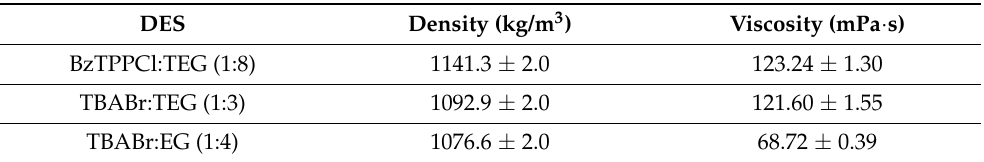
Table 4. Densities ( ρ ) and viscosities ( η ) of the prepared DESs at temperature T = 298.15 K and pressure P = 101.3 kPa a .